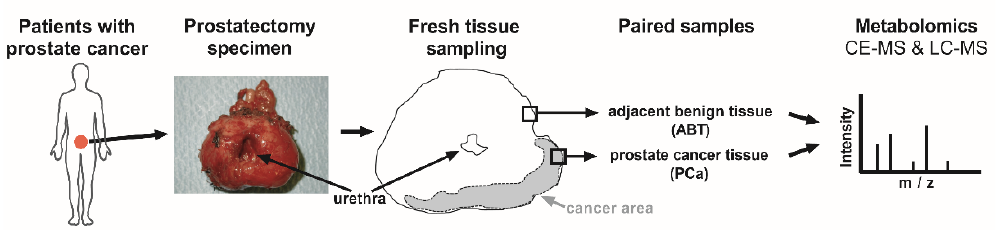
Figure 1. Study workflow. Prostate glands were removed from patients with prostate cancer (PCa), through radical prostatectomy. Anticipated PCa tissue and adjacent benign tissue (ABT) were freshly frozen. Confirmative hematoxylin and eosin staining was later applied on paraffin sections, to verify the histological assignment. Metabolites were isolated from frozen, paired PCa and ABT samples, and were subjected to capillary electrophoresis (CE) and liquid chromatography (LC), coupled with mass spectrometry (MS).